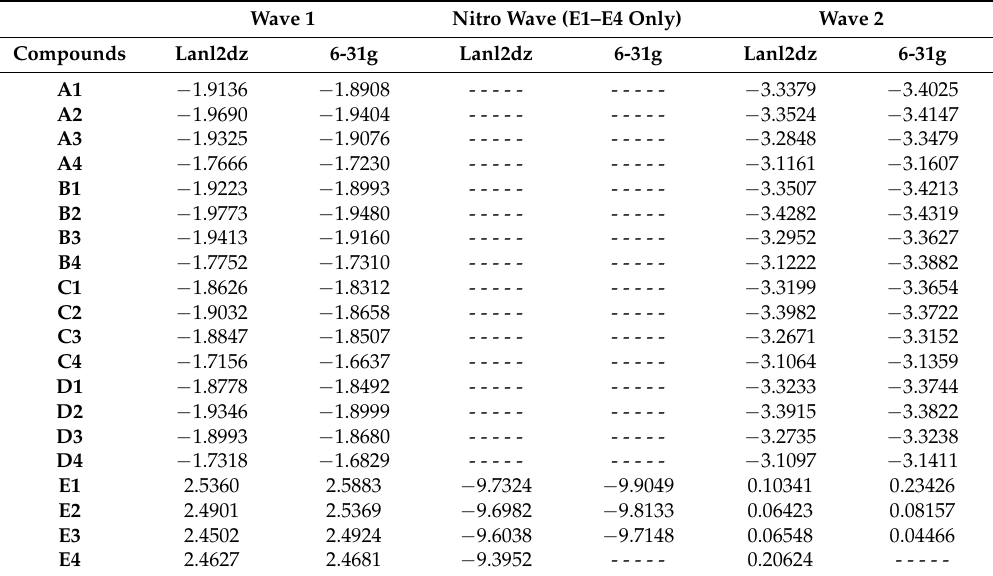
Table 3. The electrochemical cell reaction potentials ( ε cell) in volts with the standard hydrogen electrode (SHE) reduction potential set to zero for Wave 1, Nitro Wave, and Wave 2 calculated using DFT: BYL3P with lanl2dz and 6-31g basis sets in Gaussian 09.